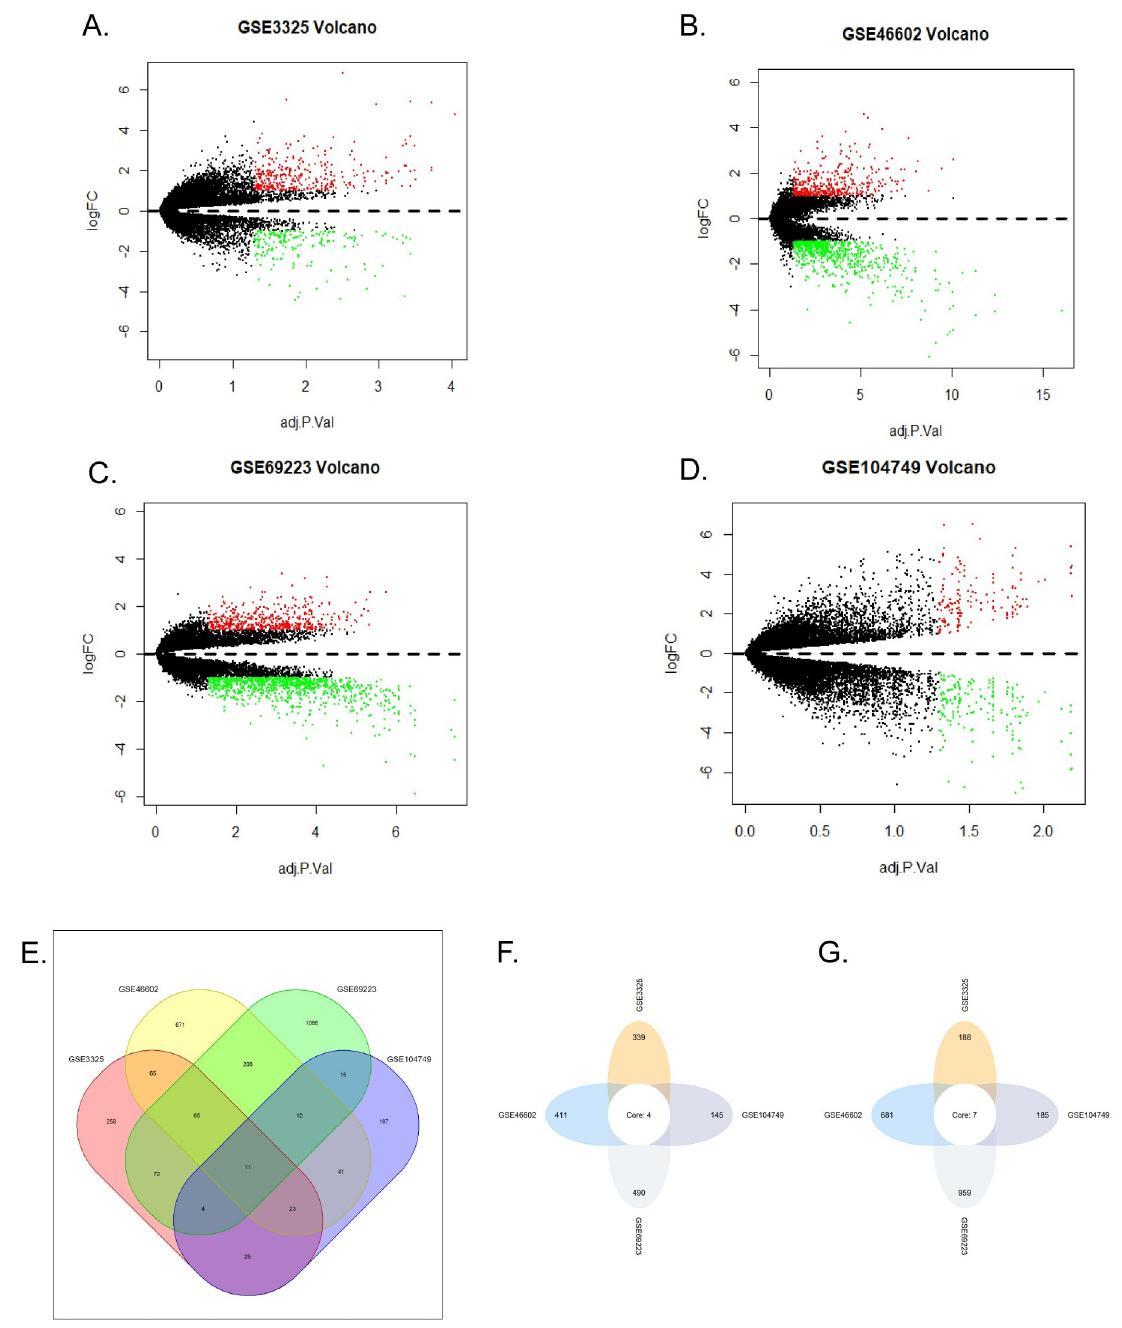
Fig 1. DEGs in GSE104749, GSE3325, GSE69223, GSE46602. (A-D) Volcano plots of all genes in four GEO databases. Red plots represented upregulated genes, green represented downregulated genes, the black plots represented the genes with no significant changes in expression. (A) GSE3325. (B) GSE46602. (C) GSE69223. (D) GSE104749. (E) Venn diagram of DEGs in four databases. The green, yellow, red, purple colors represented the DEGs of GSE46602, GSE69223, GSE104749, GSE3325, respectively. The number on the crossing area indicated the cross DEGs that were owned by different databases. (F) Upregulated genes co-expressed in the four databases. (G) Downregulated genes co-expressed in the four databases.